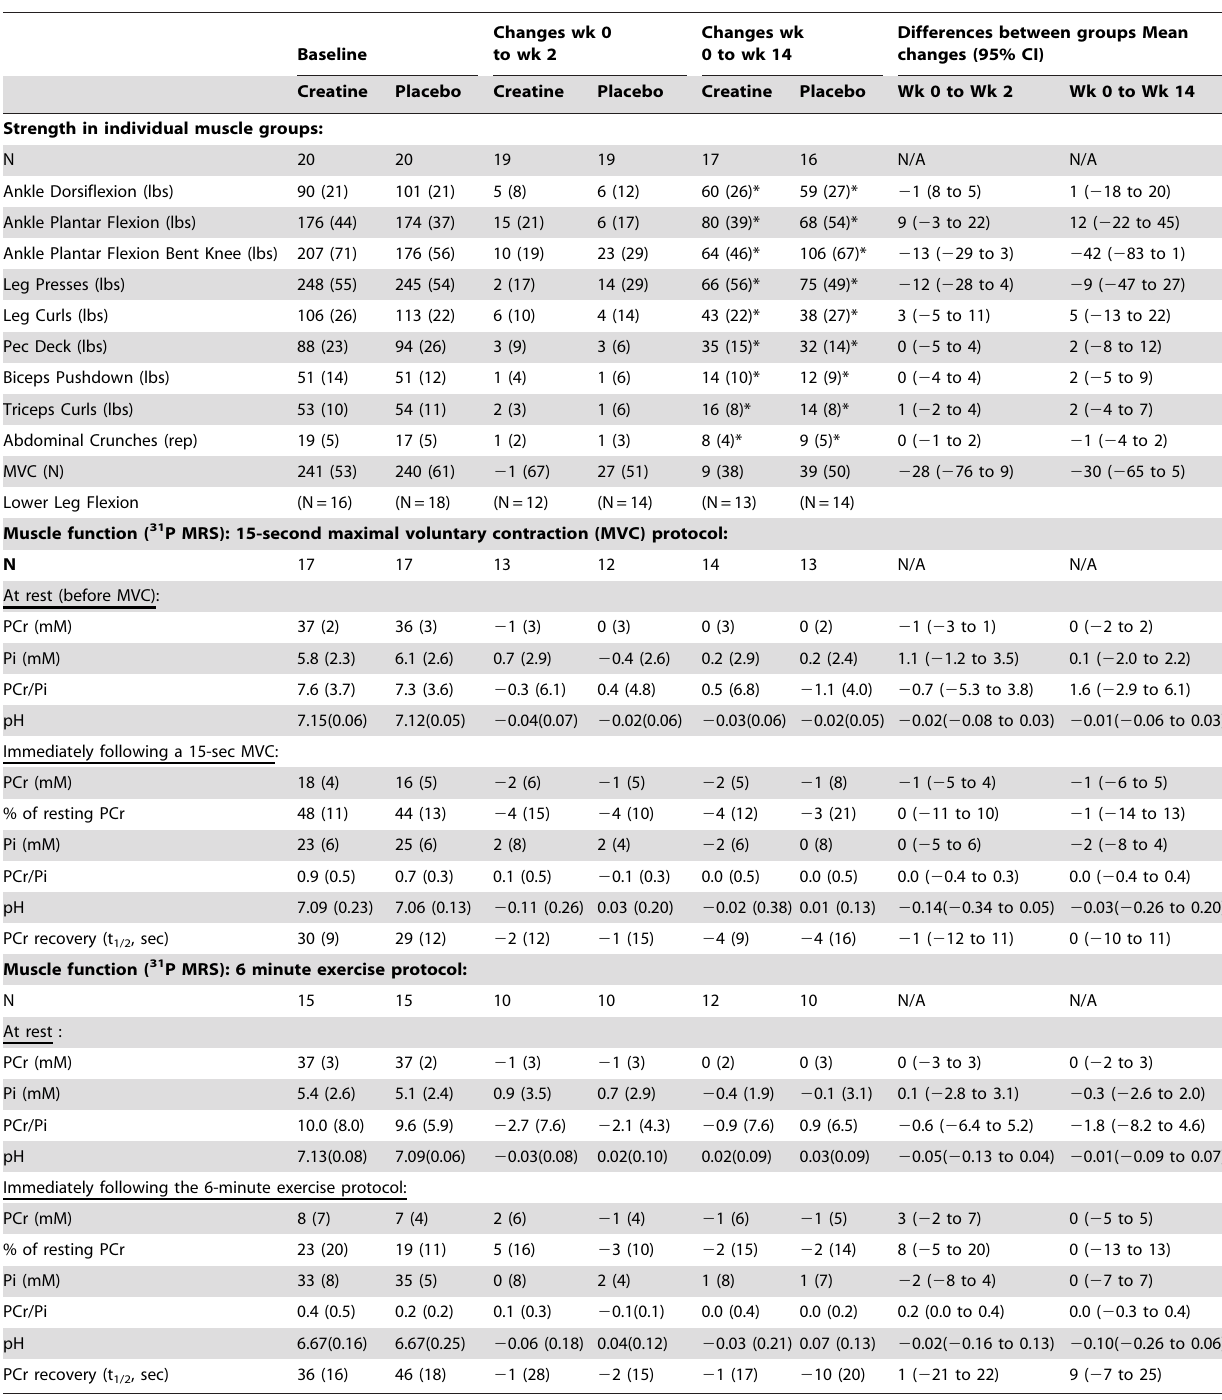
Data are mean (SD). The mean differences and the 95% confidence intervals between treatment groups of the changes from baseline at weeks 2 and 14 were determined by unpaired t-tests. Asterisks (*) are used to indicate within-group changes from baseline that are statistically significant by paired t-test (P , 0.05). Strength was measured as the 1 repetition maximum (1RM) for each muscle group (in pounds) except for the rectus abdominus, in which strength was assessed as the number of sit-ups completed in 30 seconds; and maximum voluntary contraction (MVC, in Newtons) of the tibialis anterior muscle, which was assessed during dorsiflexion of the right foot. Muscle function was evaluated using two exercise protocols that were performed inside a 1.9T magnet. The first protocol consisted of a 15- second maximum voluntary contraction (MVC) that was used to assess the rate of PCr recovery (an index of oxidative capacity). The second protocol consisted of 36 consecutive MVCs, one every 10 seconds, with cycles of 6 seconds of contraction and 4 seconds of relaxation. This latter protocol was used to assess muscle fatigue. Abbreviations: Rep, Repetitions; PCr, phosphocreatine; Pi, inorganic phosphate; PCr recovery (t K ), time needed to recover half of the baseline PCr